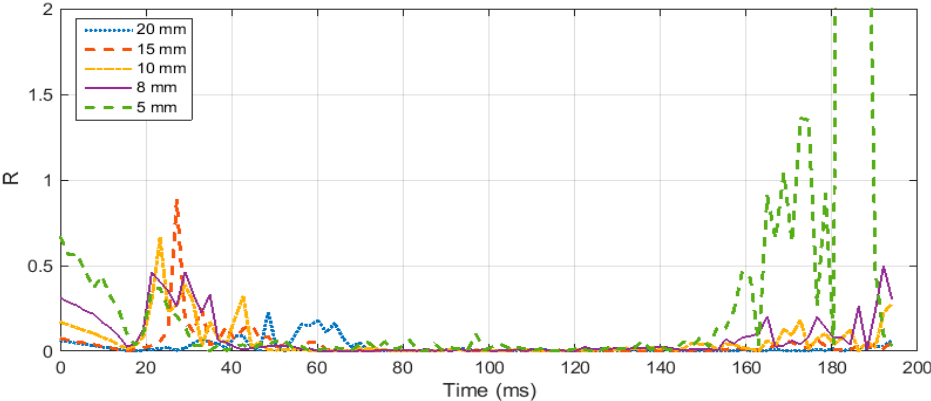
Figure 6. Ratio R for specimen thickness of 1.6 mm and diameter ranging from 5 mm to 20 mm.